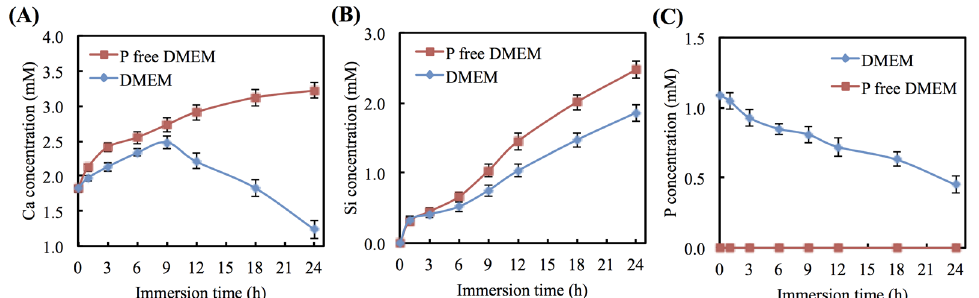
Figure 3. ( A ) Ca, ( B ) Si, and ( C ) P ion concentrations of CS after immersion in